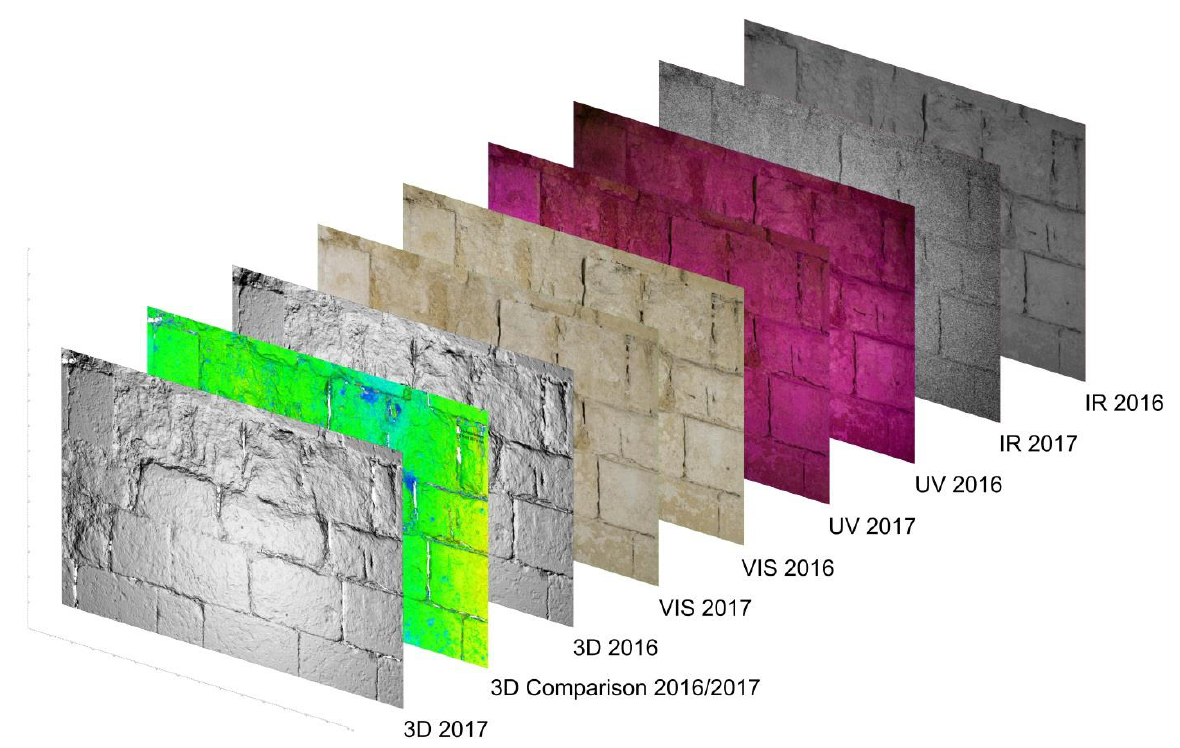
Figure 9. Trial area 3 at the Cathedral of Santa Maria de Vitoria; schematic representation of the superimposed